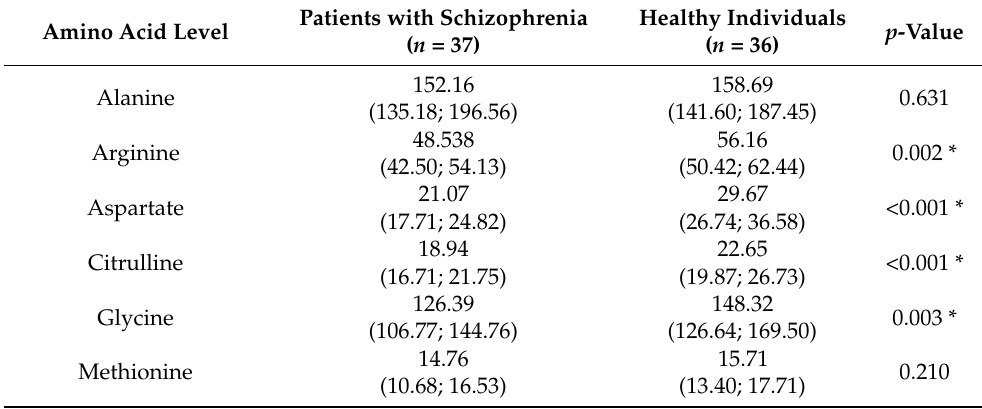
Table 2. The concentration of amino acids ( µ mol/L) in the blood serum of patients with schizophrenia and healthy individuals, Me